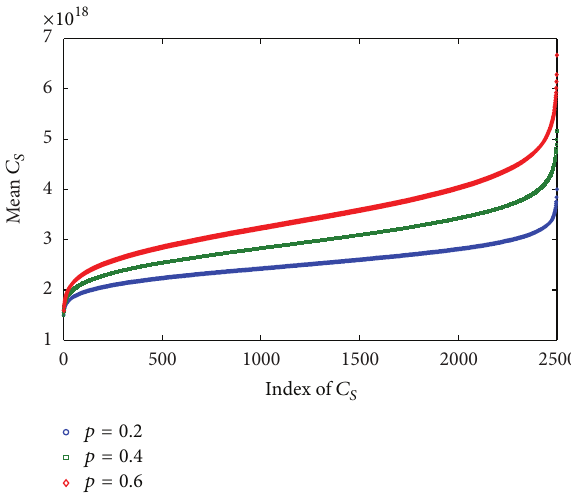
Figure 5: The mean subgraph centrality ⟨𝐶 𝑆 (𝑖)⟩ curves of the WS small-world network with three rewiring probabilities 𝑝 = 0.2 (red circles), 𝑝 = 0.4 (green squares), and 𝑝 = 0.6 (blue diamonds). All networks have 𝑁 = 2500 . All data are averaged over 50